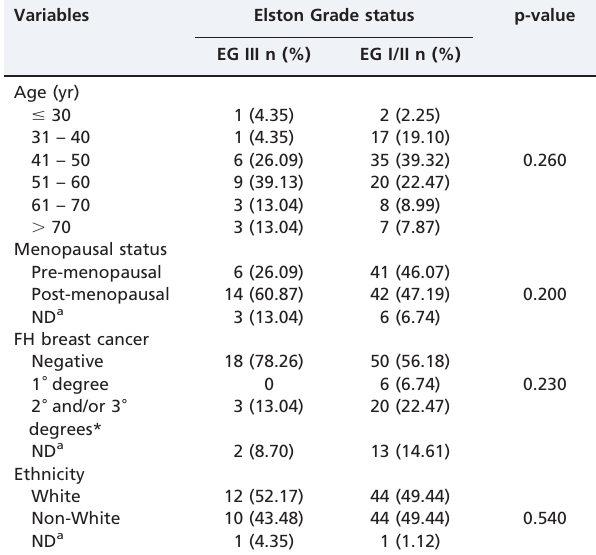
Table 2 - Demographics of the subjects by Elston Grade status (n =